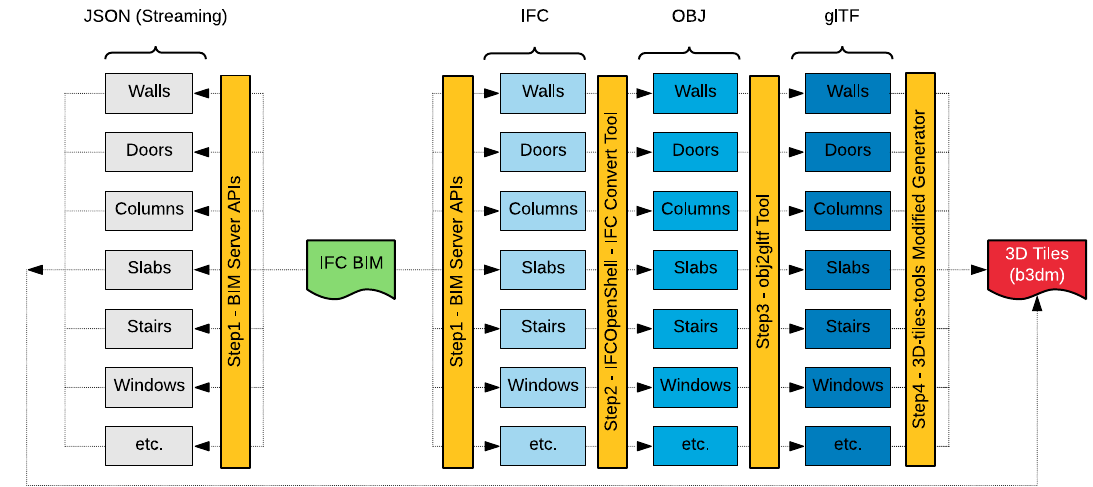
Figure 3. Proposed IFC to 3D Tiles conversion workflow.